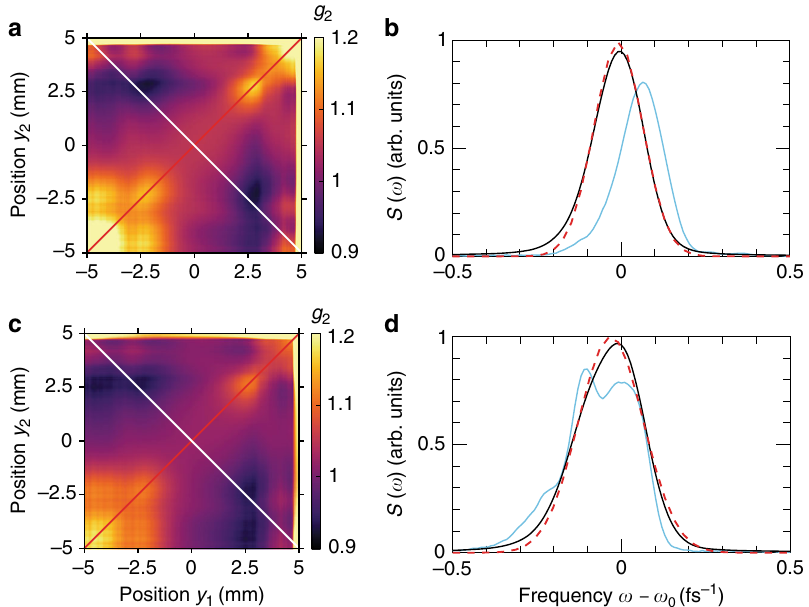
Fig. 3 Seeded mode single and multiple pulses analysis. Intensity correlation functions ( a , c ) and spectral structure ( b , d ) for the sorted pulses with the lowest ( a , b ) and highest ( c , d ) number of modes. In ( b , d ) representative single pulses are shown by blue lines, an average over 10 3 pulses is shown by black lines, and Gaussian fi t by red dashed lines. Note the different scale in frequency ω in comparison with Fig. 2b, d